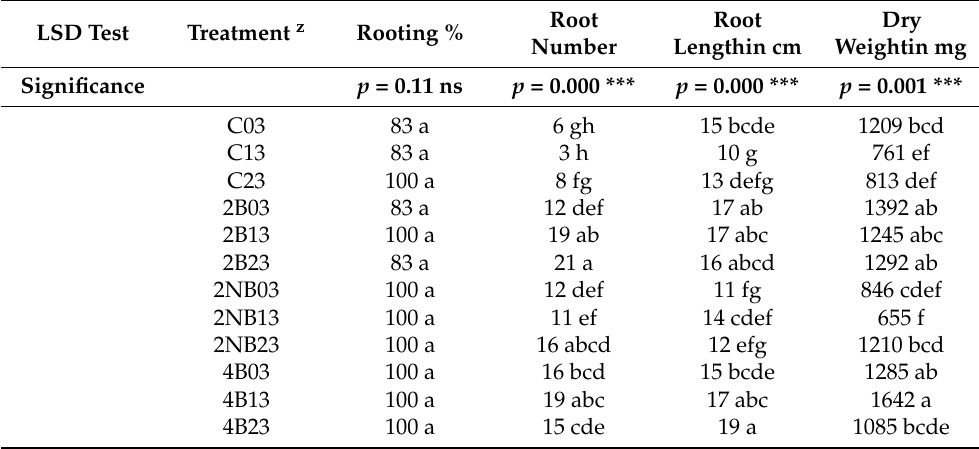
Table 4. Rooting performance of wounding/auxin treatments on stems of F. benjamina in 2020 using one-way completely randomized ANOVA. Performance was evaluated using four indices: (1) rooting rate; (2) root number; (3) root length; and (4) root dry weight. Lowercase letters indicate significant differences among treatments for a given trait ( p < 0.05; LSD test). ns or ***: nonsignificant or significant at p < 0.001, respectively. Rooting %